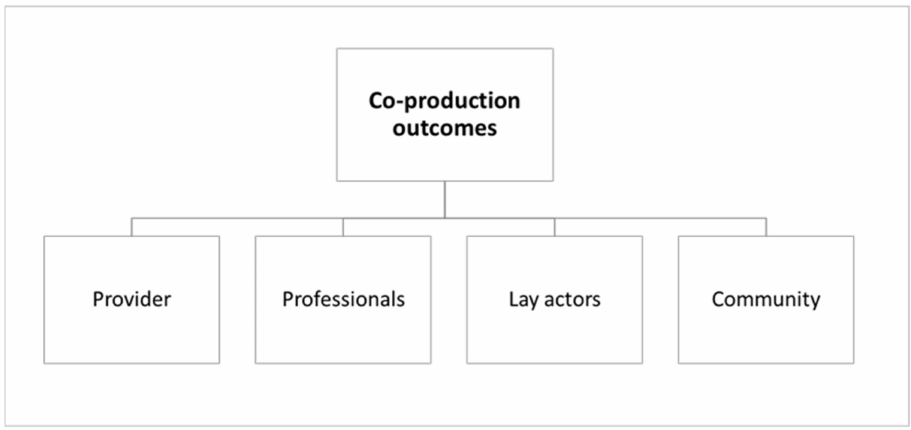
Figure 2. Outcomes’ coding